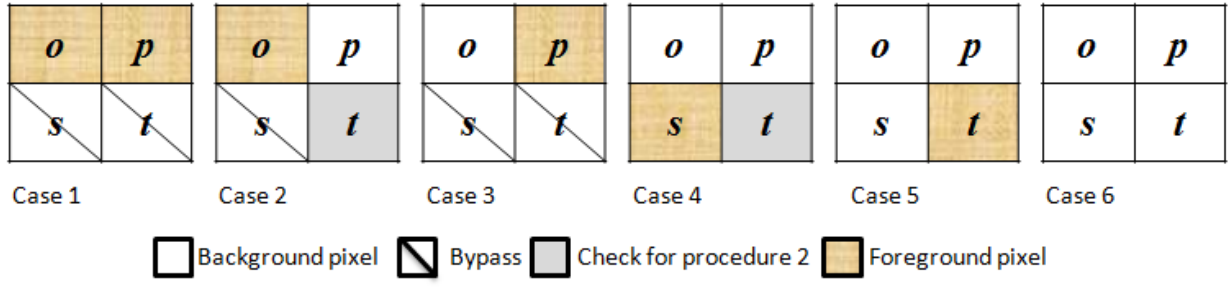
Figure 3. Six selected cases of the current block for procedure